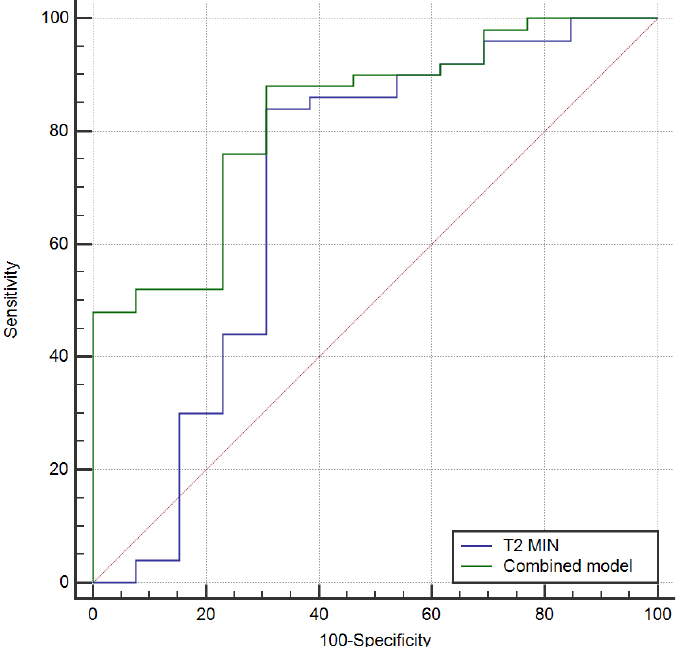
Figure 7. ROC curves comparison between T2min relaxometry parameter and combined model in predicting early treatment response to NAT.